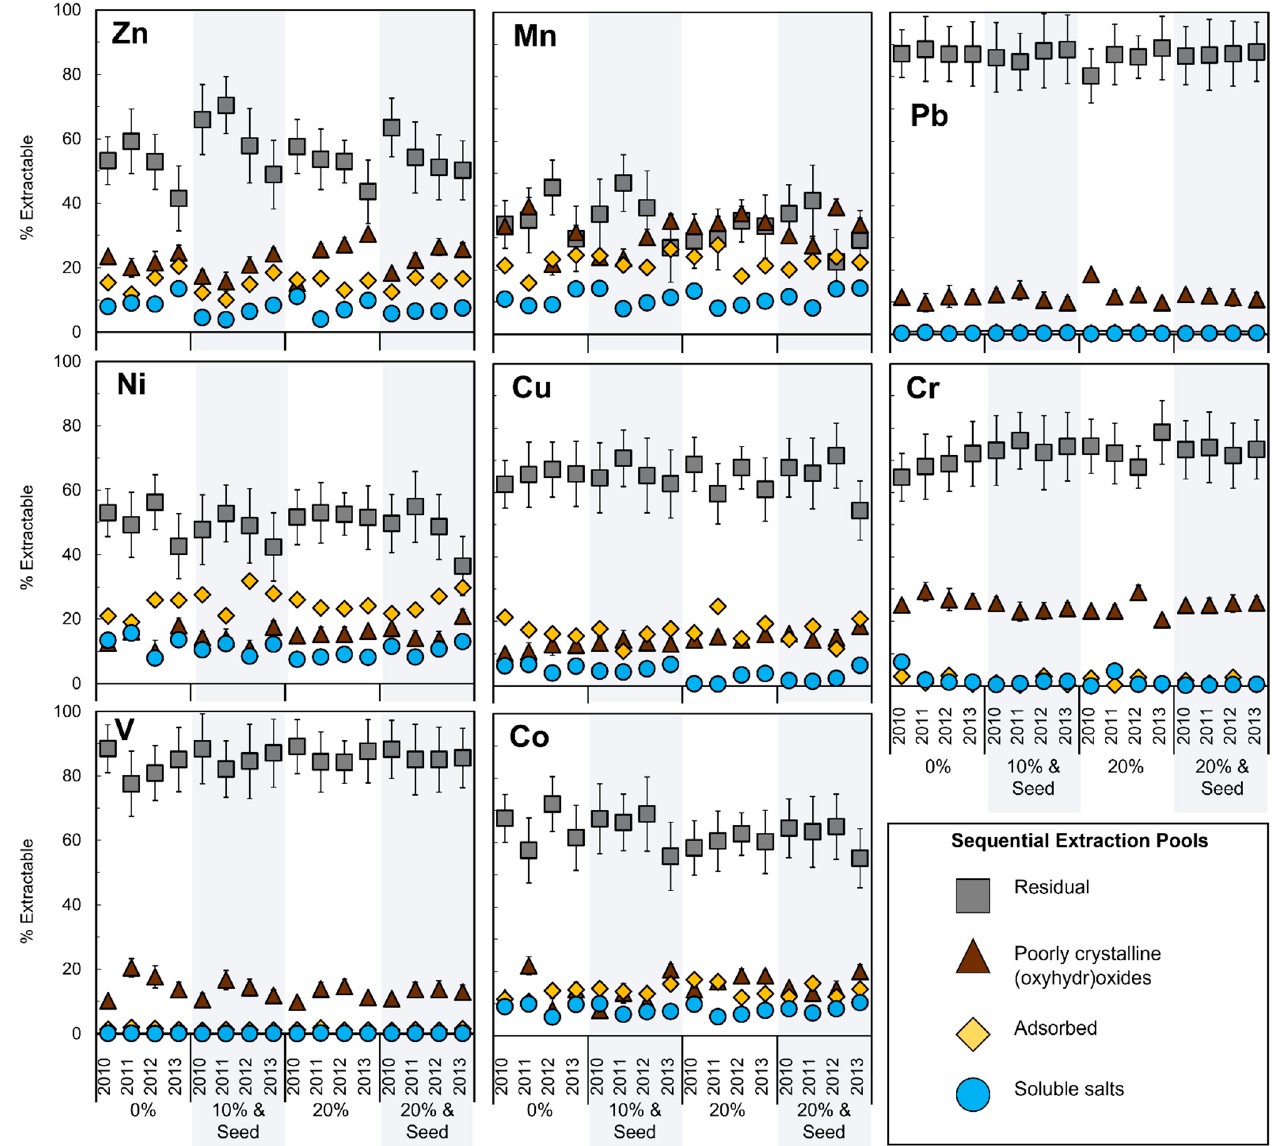
Figure 2. Depth-weighted average for the sequential extraction of metals. Extractable fractions of each element in operationally defined “water-soluble” (blue circle), “adsorbed” (yellow diamond), “poorly crystalline (oxyhydr)oxide” (brown triangle), and “residual” (gray square). Lability is reported as a percent of the total concentration for a full core length (0–90 cm) to account for the non-equivalent depth intervals (0–20, 20–40, 40–60, and 60–90 cm). Error bars denote standard deviation among quadruplicate field replicate cores ( n = 4). Shaded regions indicate seeded treatments. Full sequential extraction and total aqua regia digestion datasets are provided in the Supplemental Information (Figures S4–S11 and Tables S1–S12).